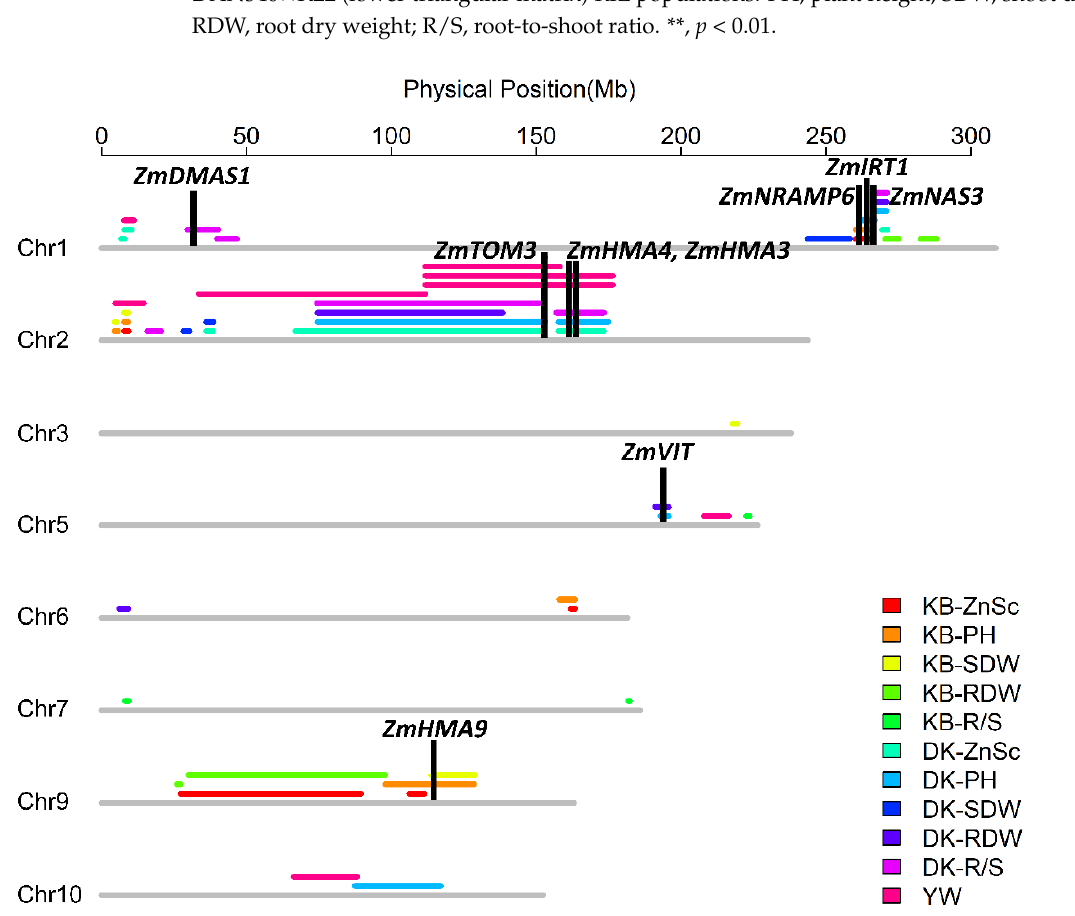
Figure 7. Fifty-four Zn efficiency-associated loci ( ZEAL s) detected on chromosome 1, 2, 3, 5, 6, 7, 9, 10 in the K22×BY815 (KB) and DAN340×K22 (DK) RIL populations, and the QTL colocalizations identified in the Ye478×Wu312 (YW) RIL population [25]. Candidate genes considered to be associ- ated with Zn deficiency uptake, transport, and redistribution ( ZmDMAS1 , ZmTOM3 , ZmNRAMP6 , ZmIRT1 , ZmHMA3 and ZmHMA4 , ZmHMA9 , and ZmVIT ) are depicted in black columns.